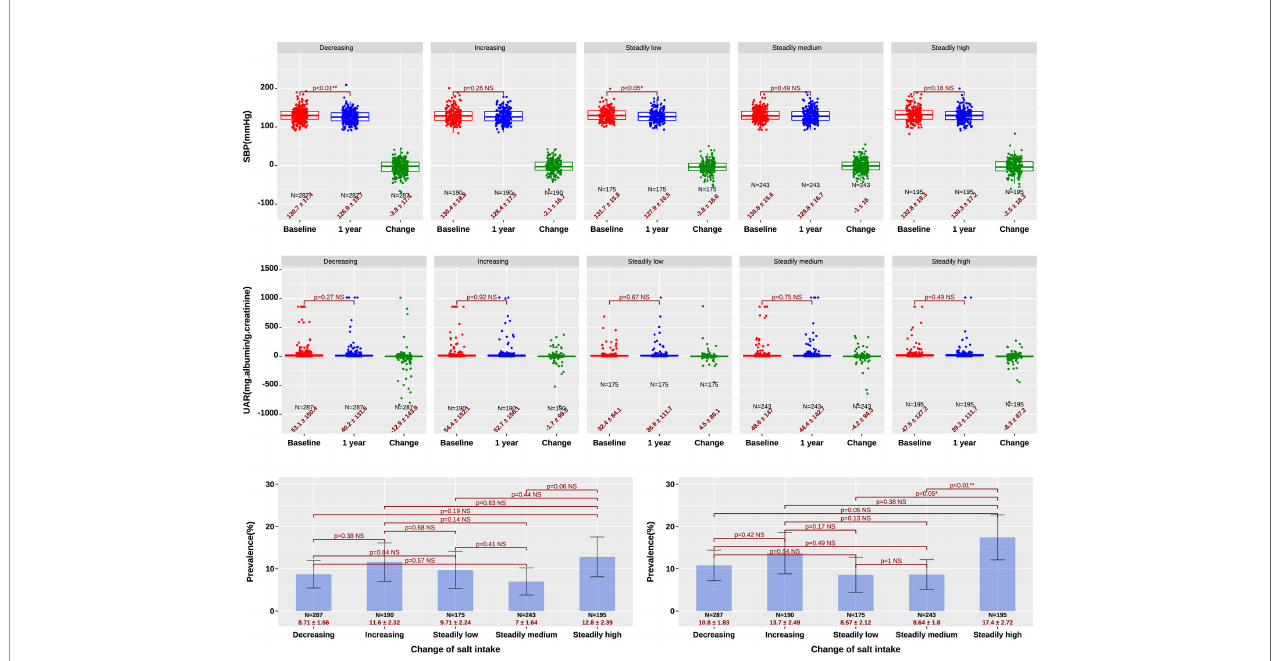
FIGURE 3 | SBP (top), UAR (mid), and prevalence of retinopathy (left bottom) and neuropathy (right bottom). Decreasing and steadily low salt intake leads to lower baseline SBP and a larger decrease in SBP. The steadily low salt group had lower UAR both at baseline and after treatment. Decreasing and steadily low salt intake leads to a slightly lower prevalence of retinopathy and a signi fi cantly lower prevalence of neuropathy. *, signi fi cant with p<0.05; **, signi fi cant with p<0.01; NS, not signi fi cant with